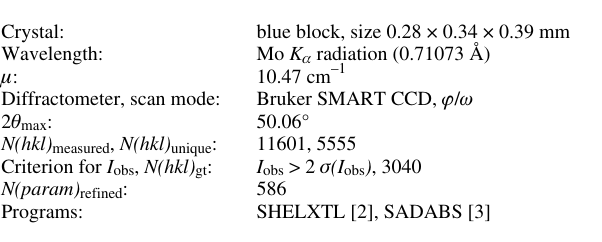
Table 1. Data collection and handling.